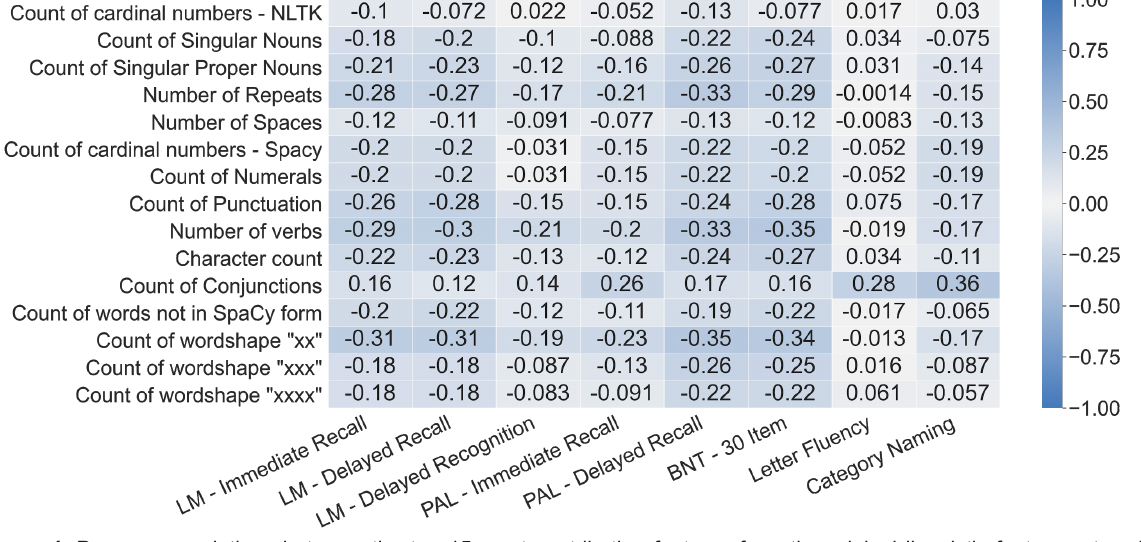
Figure 4. Pearson correlations between the top 15 most contributing features from the original linguistic feature set and the